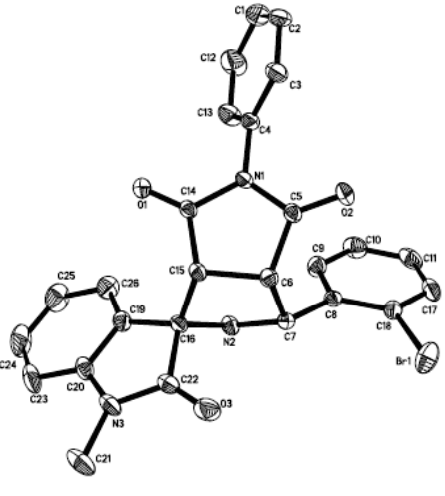
Figure 2. X-ray crystal structure of product 4k . All H atoms have been omitted for clarity.